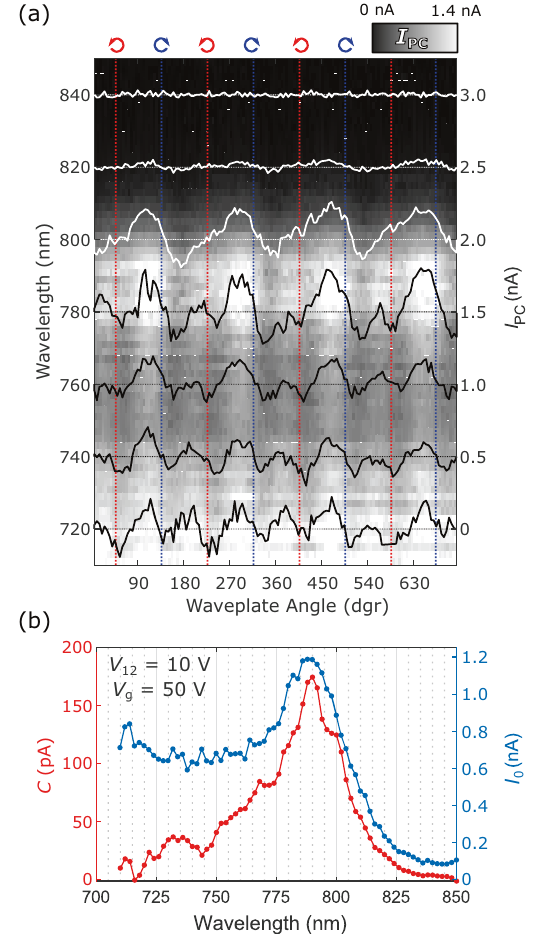
Fig. 2 Spectral dependence of the C fi tting parameter for ϕ = 30°, = 10 V, and V = 50 V. a Colormap of I V 12 g PC as a function of the waveplate angle ( x axis) and the excitation wavelength (left axis). The gray scale in the colormap represents I PC , and the solid lines (right axis) show individual I PC pro fi les at equispaced wavelengths between 720 and 840 nm. For clarity, the base level of these pro fi les has been shifted vertically in steps of 0.5 nA. b I 0 (blue, right axis) and C (red, left axis) parameters, obtained from least-square fi tting of Eq. 1 to the data shown in a , as a function of the excitation